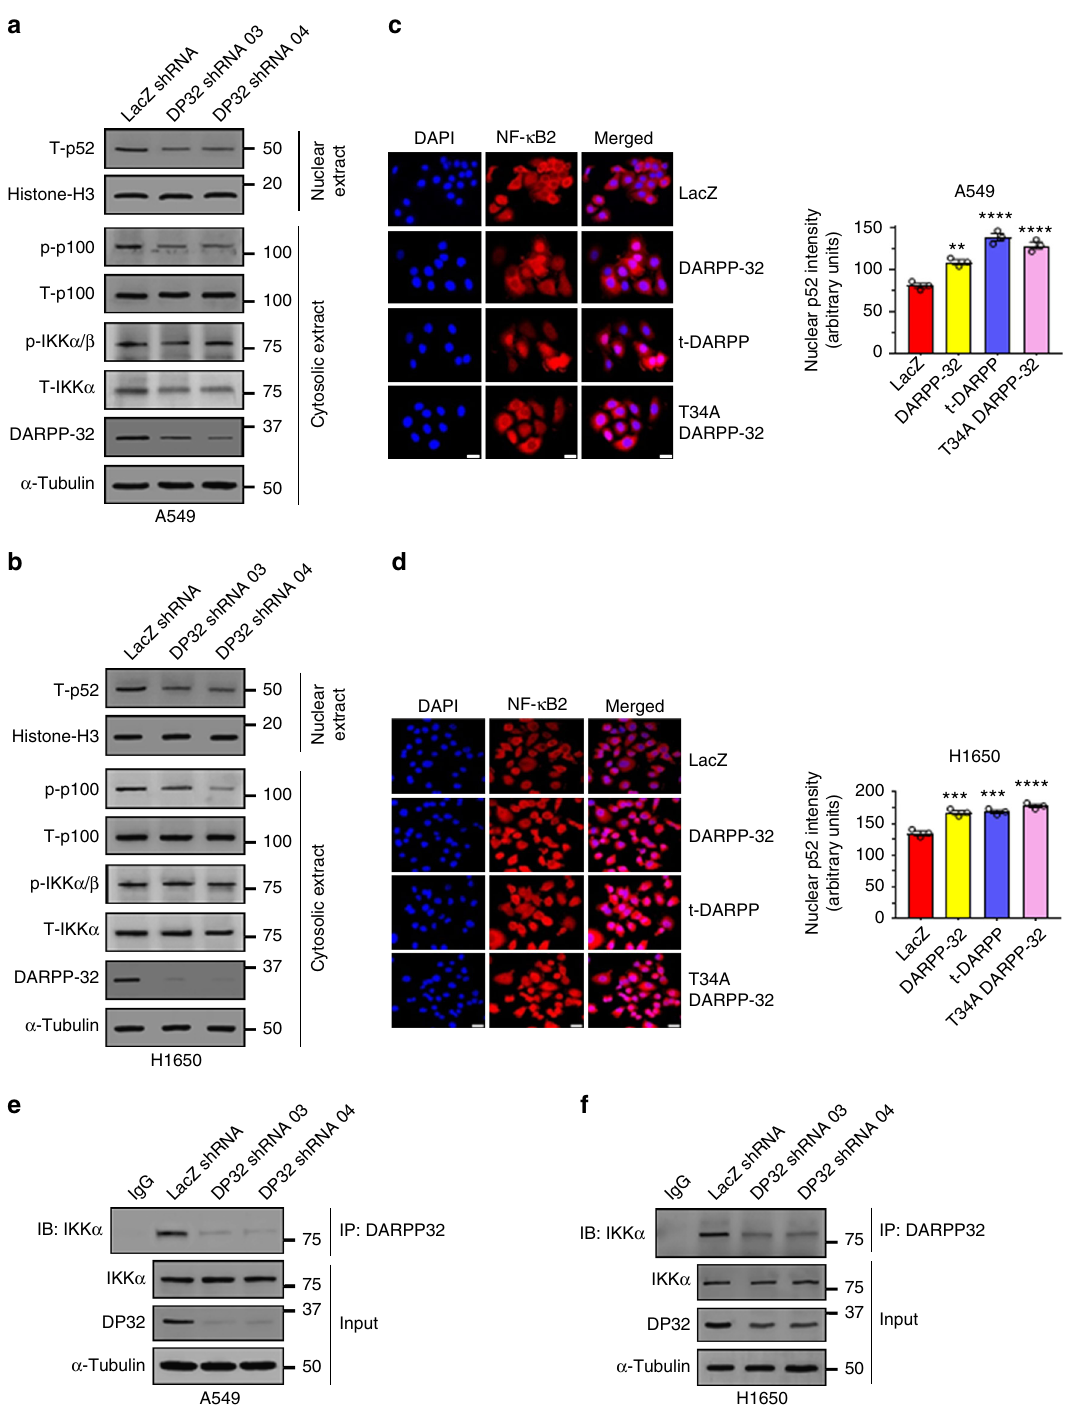
Fig. 4 DARPP-32 knockdown inhibits non-canonical NF- ĸ B2 signaling. a Nuclear fractions of A549 and b H1650 cells expressing control or DARPP-32 (DP32) shRNAs were immunoblotted with antibodies against total p52 (T-p52) and histone H3 (loading control). Cytosolic fractions were also collected and subjected to western blotting using antibodies against phosphorylated p100 (p-p100), total p100 (T-p100), phosphorylated IKK α / β (p-IKK α / β ), total IKK α (T-IKK α ), DARPP-32 and α -tubulin (loading control). c Immuno fl uorescence studies were performed using a monoclonal NF- ĸ B2 antibody (that detects both p100 and p52 proteins) on A549 and d H1650 cell lysates expressing control or DARPP-32 shRNAs. Nuclei were labeled with DAPI. Average red fl uorescence intensity of all nuclei was calculated using ImageJ software. Experiments were repeated at least three times. Each open circle on a graph represents an independent experiment. Scale bar, 20 µ m. Error bars indicate SEM ( n = 3). ** P < 0.01, *** P < 0.001 and **** P < 0.0001, one-way ANOVA followed by Dunnett ’ s test for multiple comparison. e A549 and f H1650 cells transduced with lentivirus encoding control or DARPP-32 shRNAs (DP32 shRNAs) were immunoprecipitated (IP) with anti-DARPP-32 antibody and immunoblotted (IB) with antibody against IKK α . Total cell lysates (Input) were subjected to western blotting using antibodies against IKK α , DARPP-32 (DP32) and α -tubulin (loading control). All immunoblots are representative of three independent experiments. Uncropped images of depicted immunoblots are shown in Supplementary Figs. 18,